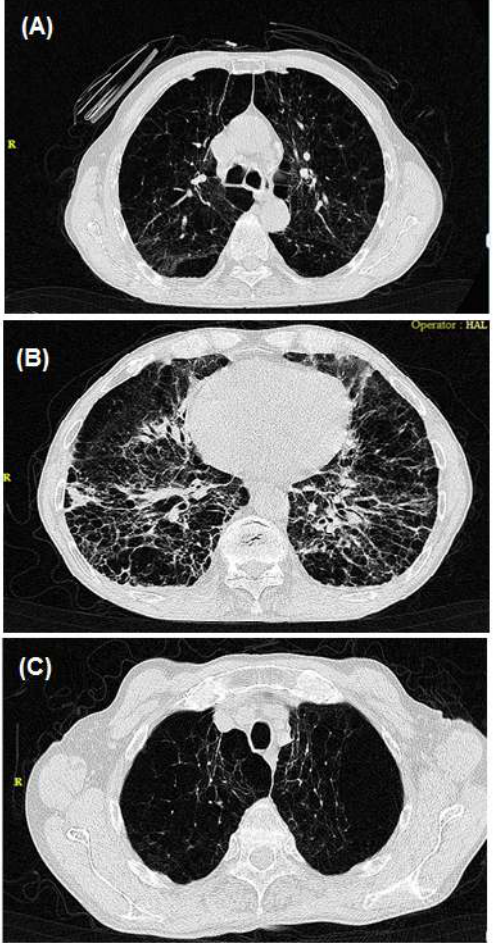
Figure 1 (A-C): lung